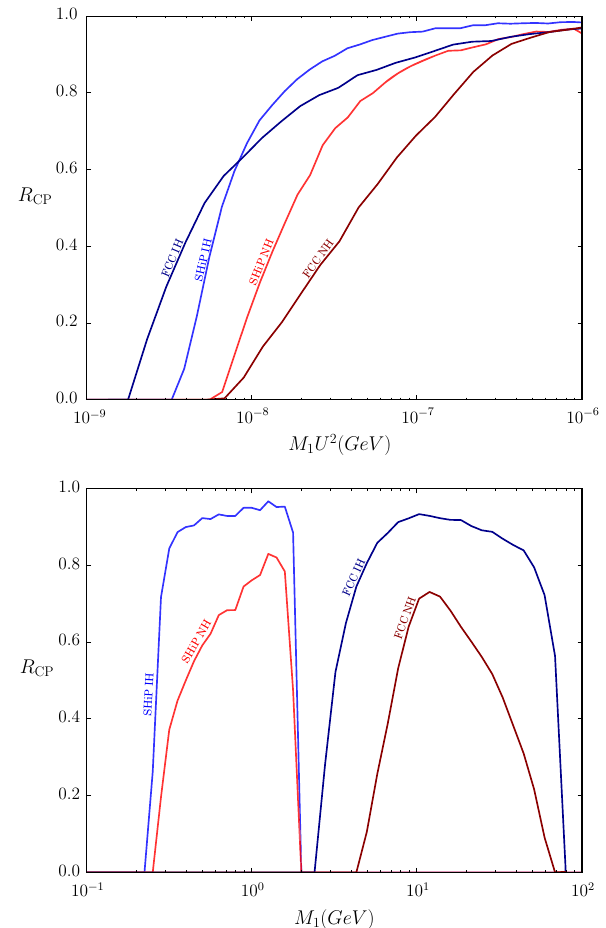
Fig. 6 CP fractions for a 5 σ discovery of leptonic CP violation for the two neutrino orderings and the two experiments SHiP and FCC-ee, as a function of γ (shown in units of the more physical quantity M 1 U 2 ) for M 1 = 1 GeV in SHiP and M 1 = 30 GeV in FCC-ee ( up ), and as a function of M 1 for γ = 4 ( down )